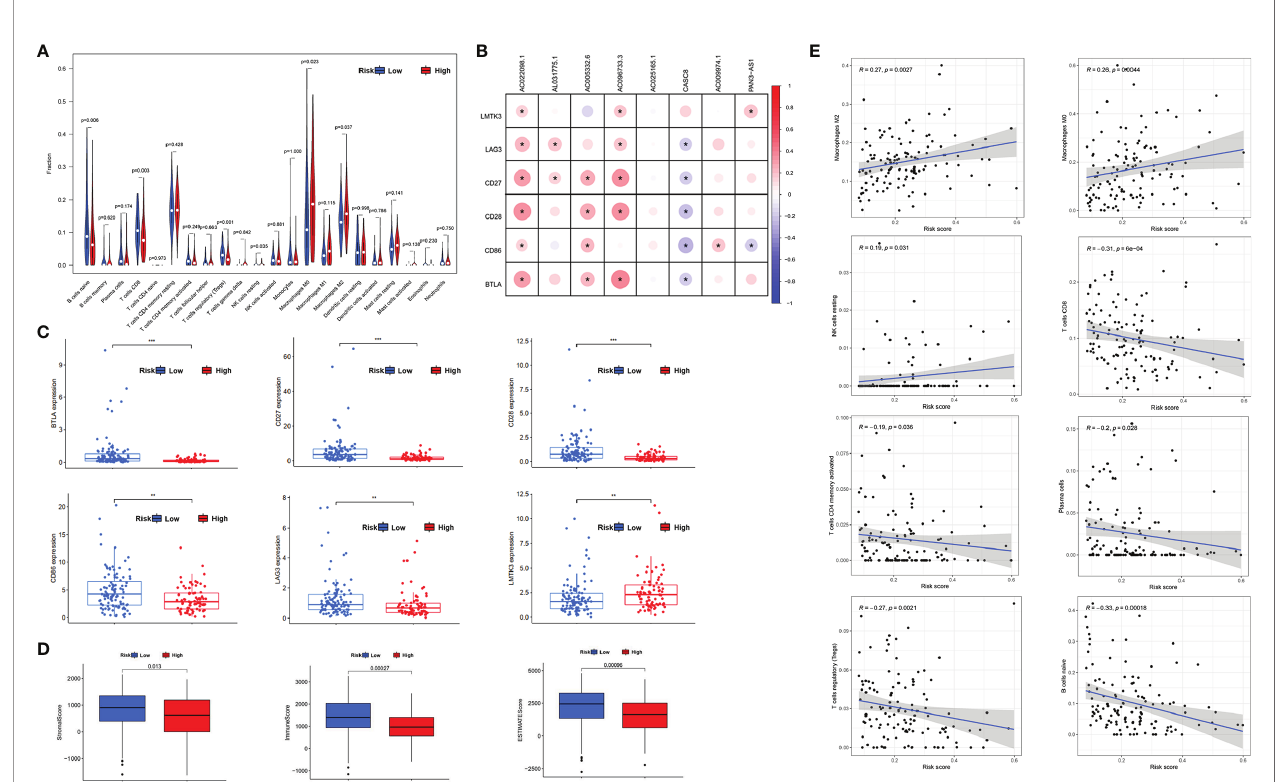
FIGURE 7 | The relationship between m5C-related lncRNAs and tumor-in fi ltrating lymph cells. (A) Violet plot showed the 22 tumor-in fi ltrating lymph cells distribution in PDAC patients with different m5C-related lncRNA risk scores. (B) The connection between the immune associated genes and the selected m5C- related lncRNAs. (C) Scatter diagram revealed the expression of immune-related genes in low- or high-risk groups, respectively. (D) Box plots indicated the proportion of stromal and immune cells in PDAC tissues via ESTIMATE R package method. (E) Correlation between the lymph cells and m5C-related lncRNA risk scores. * p < 0.05, ** p < 0.01, *** p <